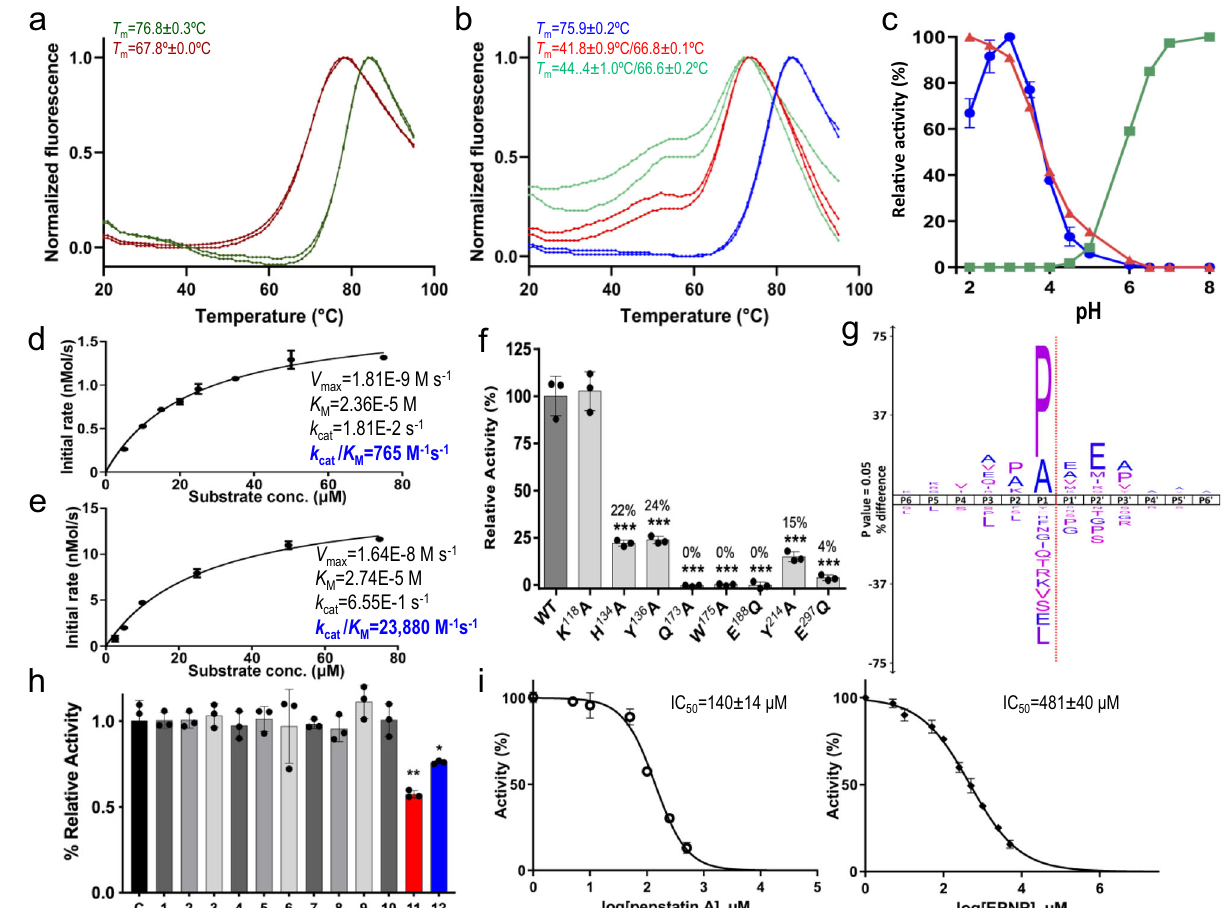
Fig. 2 | Thermal stability, peptidolytic activity and inhibition assays. a Differential scanning fl uorimetry showing duplicate curves of temperature- dependent fl uorescence variation during the thermal denaturation of neprosin (darkred)andpro-neprosin(green).Theinsetmidtransitiontemperatures( T m )are theaveragein fl ectionpointsofthetworespectivecurves. b Sameas( a ),illustrating the effectof TCEP asa reducing agent at 5mM (red)and 10mM (green) compared with untreated pro-neprosin (blue). c The pH-dependent activity of pepsin (red), trypsin (green) and neprosin (blue) on a fl uorescent BSA substrate. For neprosin, dataaremeans±SD( n =3independentexperiments).Valuesfortrypsinandpepsin were measured once. d , e Kinetics of the neprosin-mediated cleavage of the fl uorogenic peptides ( d ) FS6 (100nM neprosin) and ( e ) FS6-QPQL (25nM nepro- sin). The insets show the corresponding V max , k cat , K M and k cat / K M values. f Peptidolytic activity of wild-type (WT) neprosin and mutants on the fl uorogenic FS6-QPQLpeptide.Statisticalsigni fi cancedeterminedbytwo-sidedStudent ’ s t -test